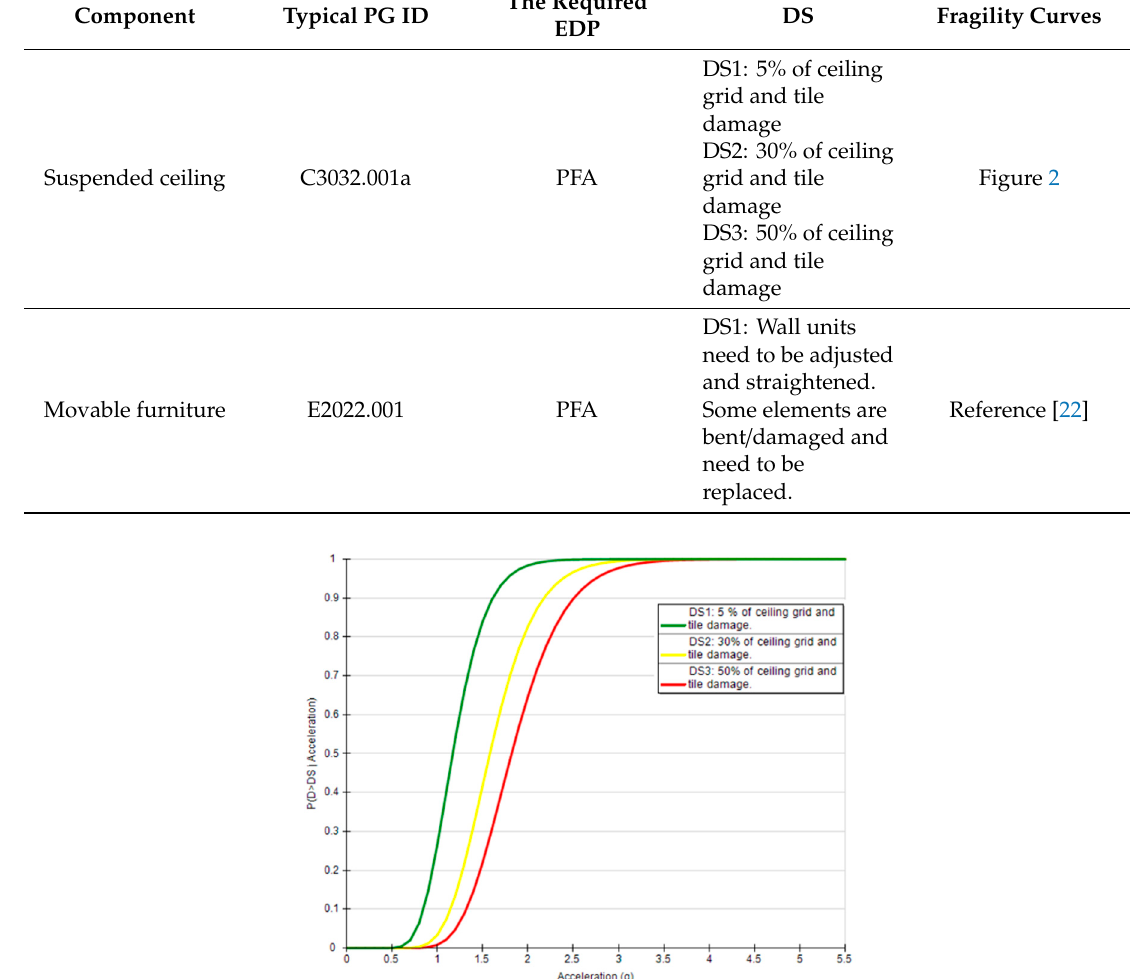
Figure 2. Fragility curve for the suspended ceiling.